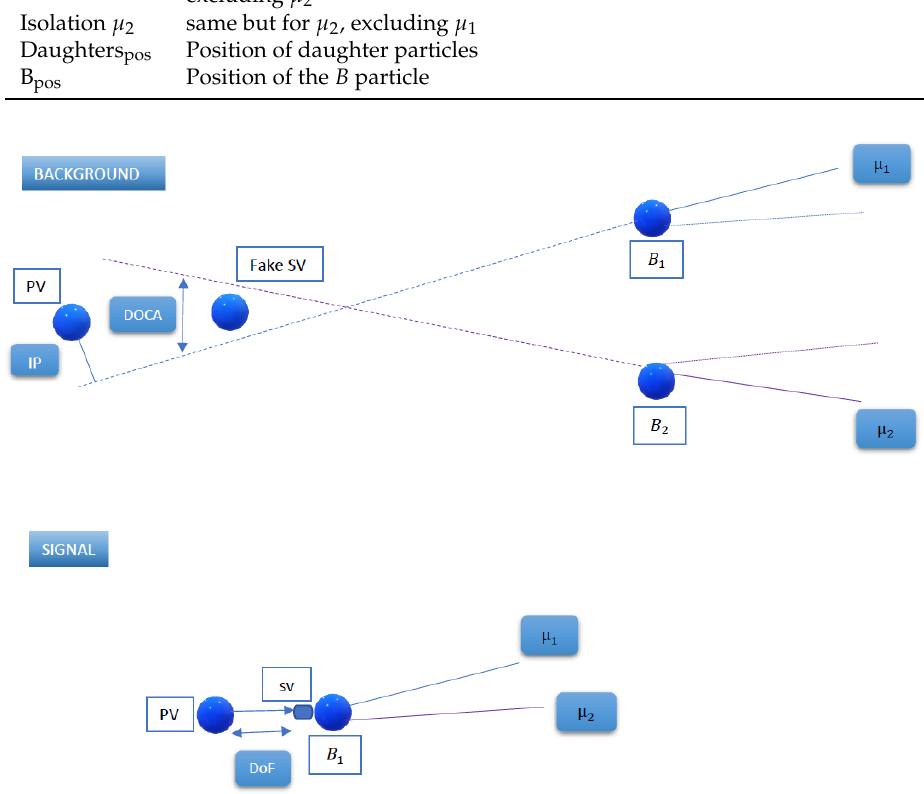
Figure 4. Characterization of the signal and background and definition of several variables to discriminate between them. For the µµ background, the usual candidates are formed by muons from different B mesons that are incorrectly matched